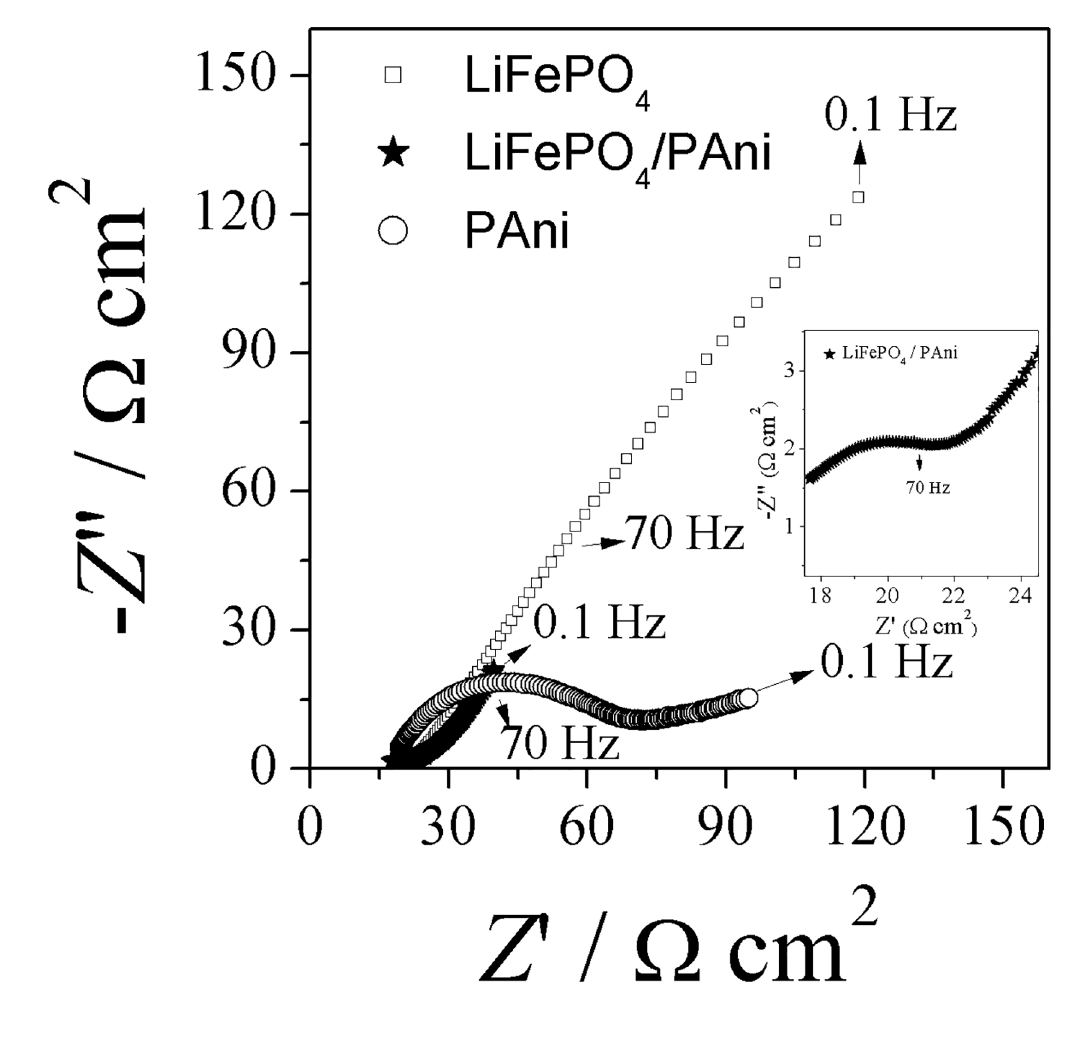
, PAni and LiFePO /PAni, in a 1.0 mol L -1 LiClO in EC:DMC 1:1 ( V / V ), in the range 10 4 to 10 -1 4 4 4 /PAni is shown as inset. 4 4